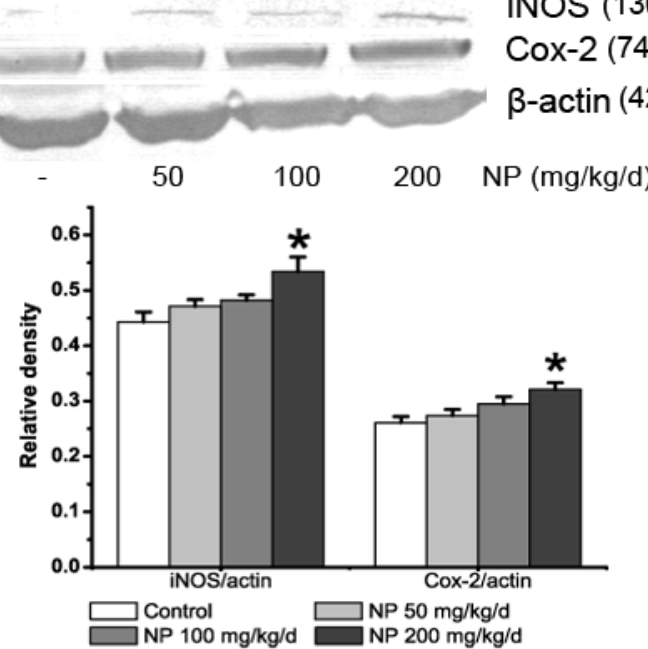
Figure 2. Western blotting analysis of the expression of iNOS (130 kD) and COX-2 (74 kD) in the brains of control mice and NP-treated mice. The relative ratio of colorimetric density of iNOS/ β -actin and COX-2/ β -actin was analyzed by Quantity one (Bio-Rad, USA). β -actin was used as an internal control. All experiments were carried out at least in duplicate on three different animals and values are expressed as mean ± S.E.M. (n = 3) *P < 0.05 vs. the vehicle